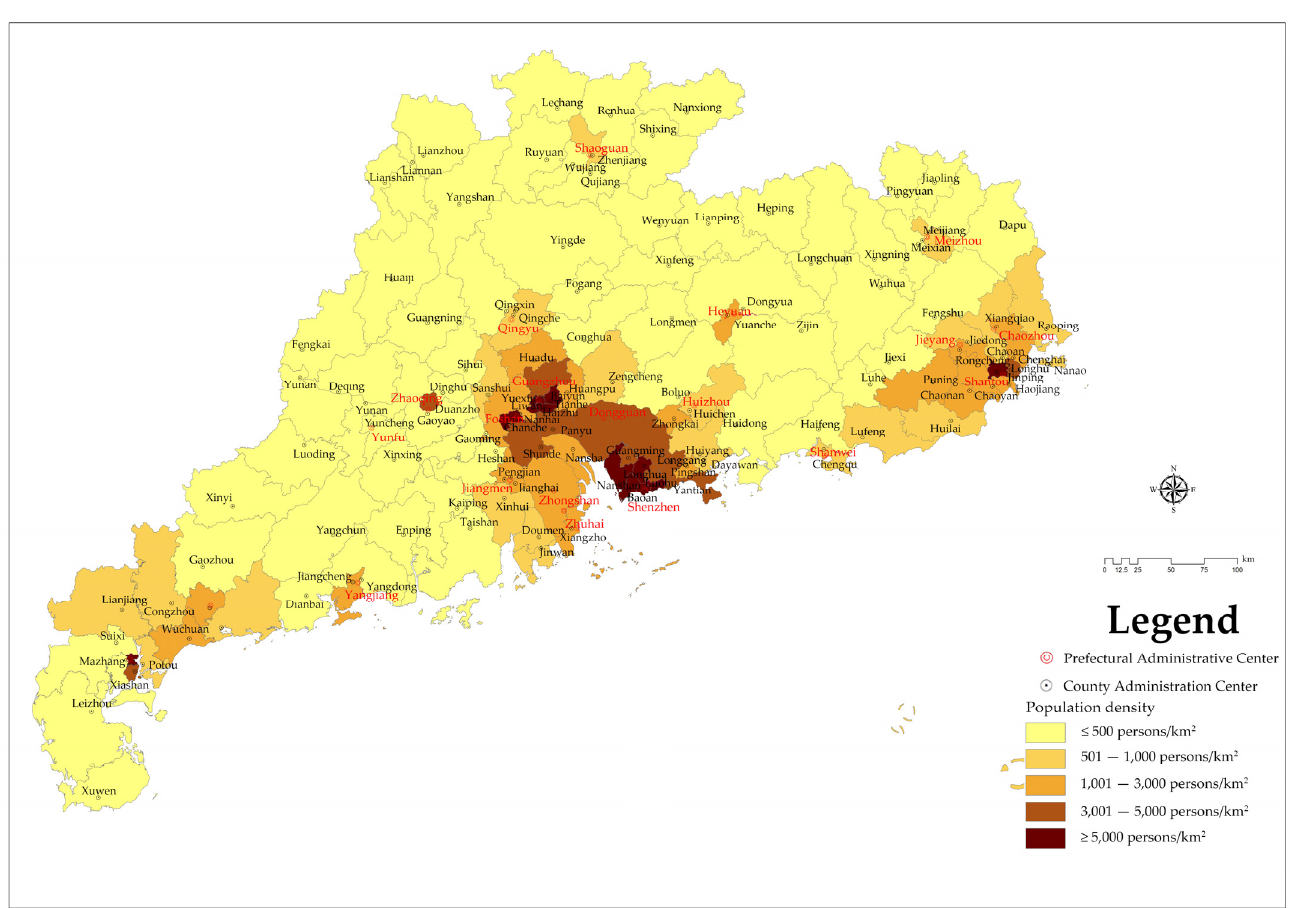
Figure 4. Hierarchical distribution of population density.